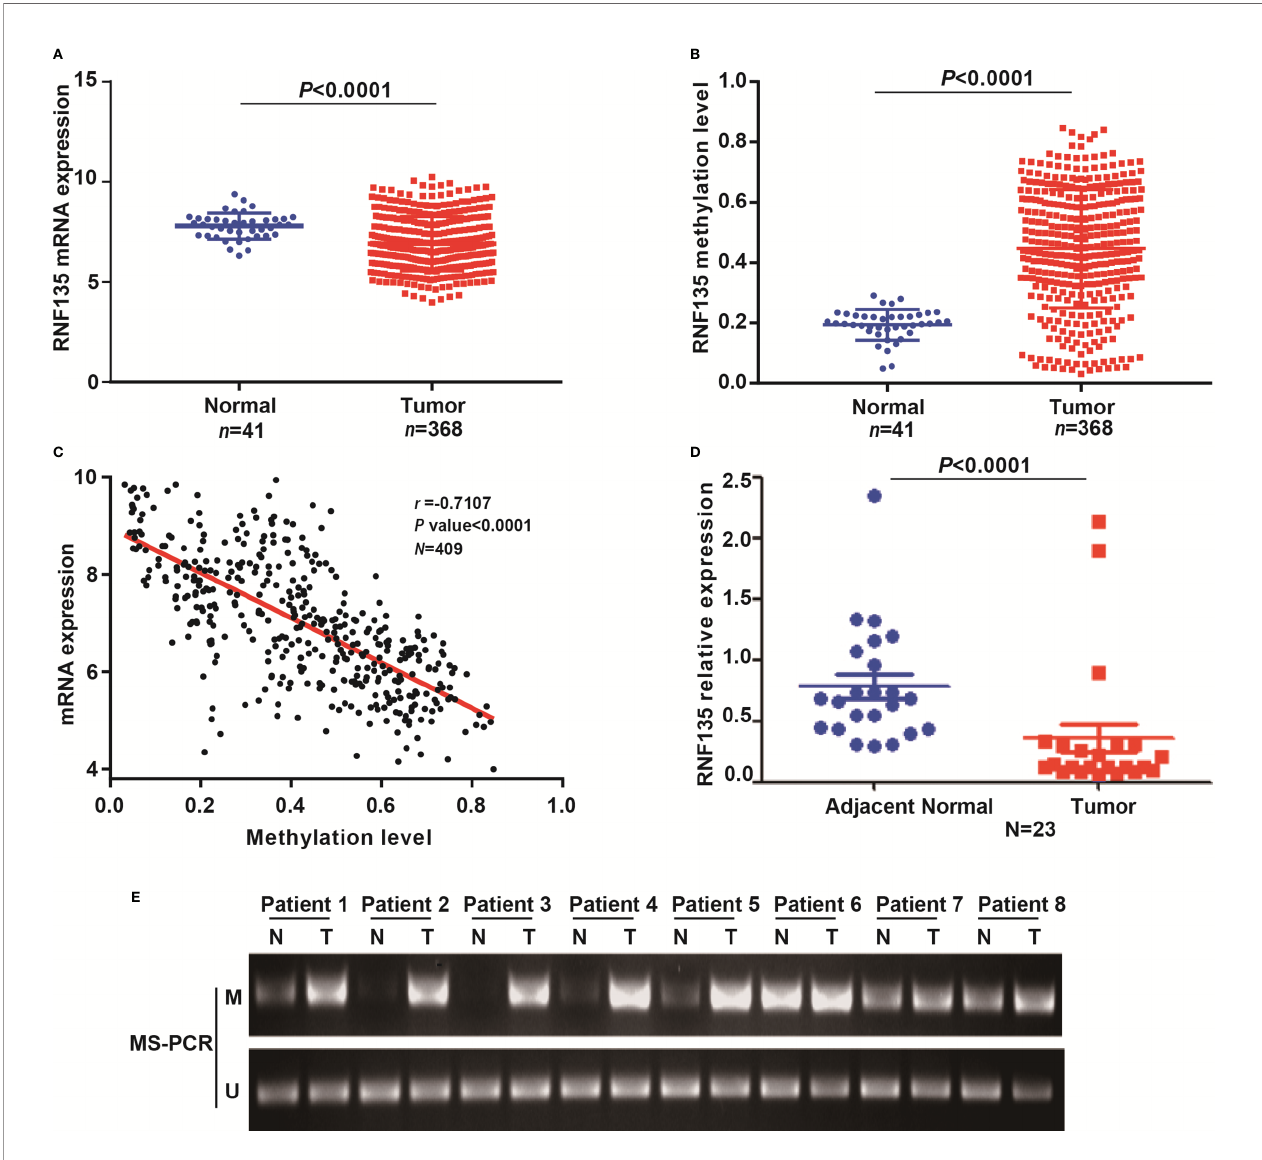
FIGURE 1 | RNF135 expression and methylation levels and analysis of their correlation in HCC tissues. (A) RNF135 mRNA expression data from TCGA were analyzed. (B) The average methylation level of 10 CpG sites was used to evaluate promoter methylation of RNF135. Promoter methylation levels in HCC tissues and adjacent non-tumor tissues were analyzed with TCGA data. (C) The correlation between RNF135 mRNA expression and methylation status was analyzed with TCGA data (Spearman ’ s correlation r = − 0.7017, n = 409, p -value <0.0001) (D) RNF135 mRNA expression was measured by real-time quantitative PCR in 23 pairs of samples from SYSUCC. (E) MS-PCR (M, methylation; U, unmethylation) was used to detect methylation status in 8 pairs of samples from